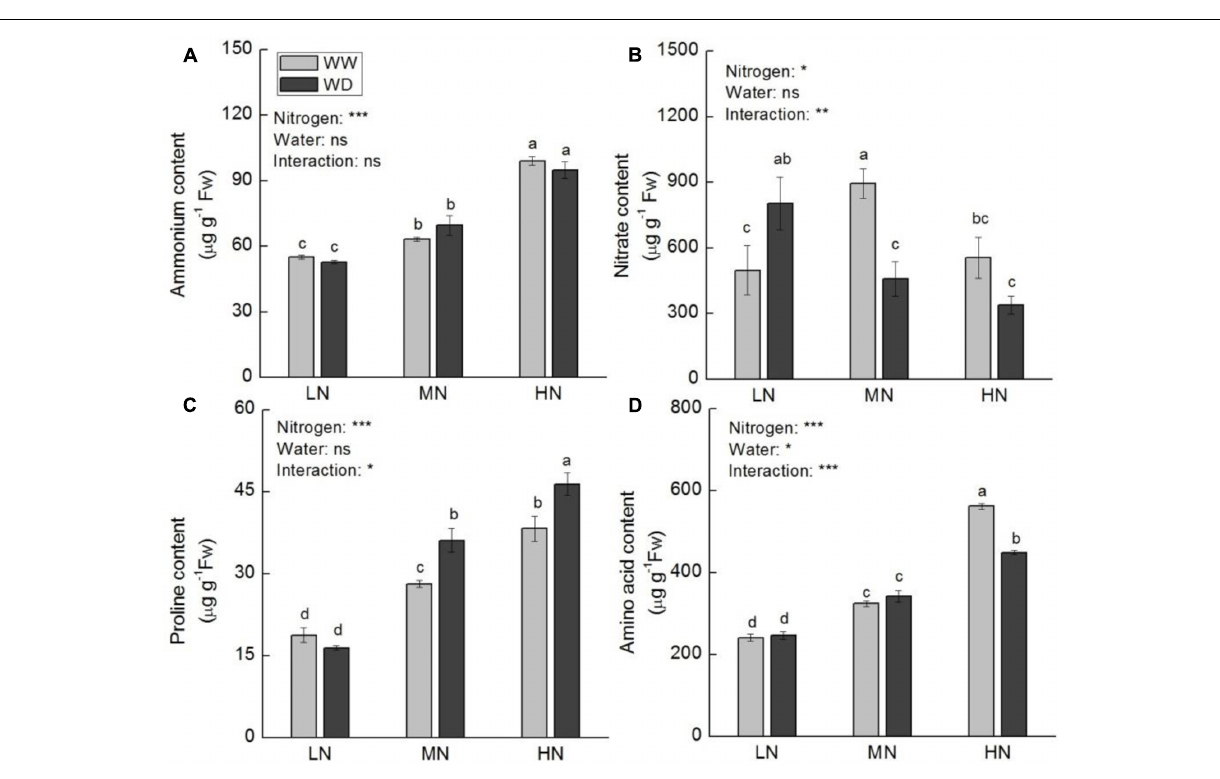
FIGURE 6 | Comparison in the contents of ammonium (A) , nitrate (B) , proline (C) , and free amino acid (D) in rice plants grown udner different nitrogen and water conditions. Data refers to mean ± SE ( n = 4). P -values of the two-way ANOVAs of nitrogen, water, and their interaction are indicated: ns, not significant; ∗ P < 0.05; ∗∗ P < 0.01; ∗∗∗ P < 0.001. Bars with the same letter are not significantly different by LSD test. WD, water deficit; WW,